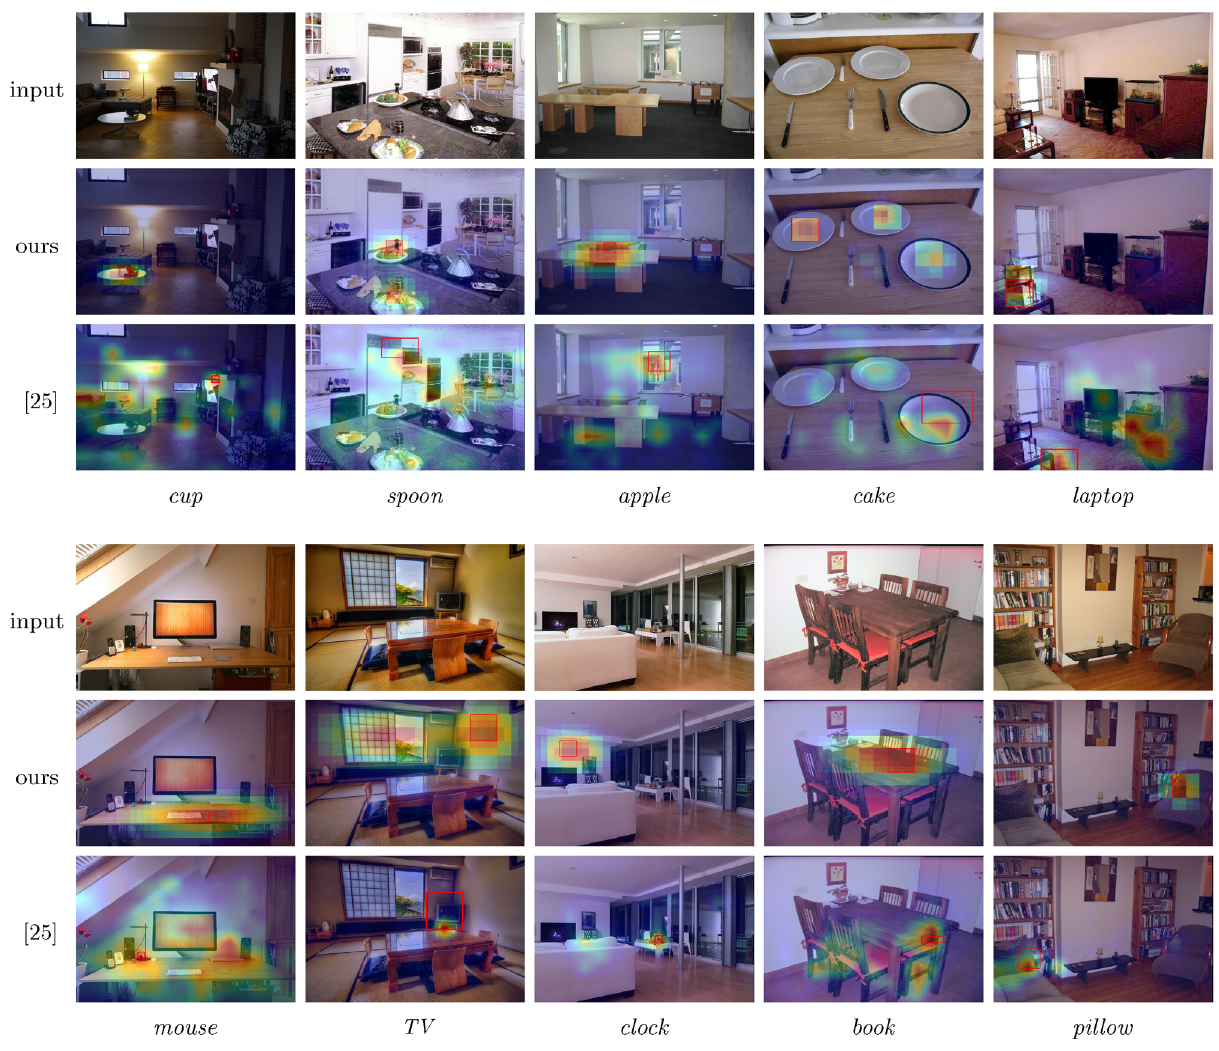
Fig. 8 Qualitative comparison against Tan et al.’s method for bounding box prediction. Top row: original image. Middle row: our results. Bottom row: results of Tan et al.’s method. The inserted object for each image is labeled at the bottom of each